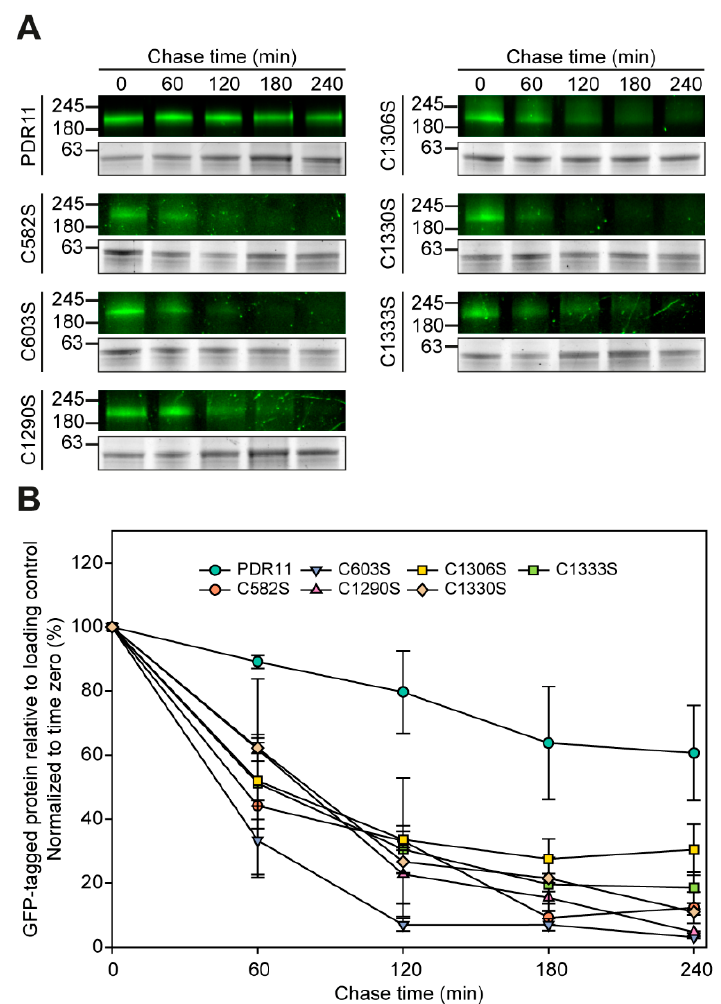
Figure 5. GFP-tagged Pdr11p cysteine mutants are less stable than the wild type. hem1 ∆ aus1 ∆ pdr11 ∆ cells expressing genomically integrated wild-type and mutant Pdr11p-GFP were treated with cycloheximide and processed at the indicated time points to monitor the stability of the ABC transporter. ( A ) Upper panels display in-gel GFP fluorescence and lower panels in-gel fluorescence detection at ~63 kDa for loading control. ( B ) The in-gel fluorescence intensities of GFP-tagged Pdr11p or cysteine mutant variants were quantified and normalized to the intensities of the loading control at ~63 kDa for each time point. Results are expressed as the percent change from time zero, which was set at 100%. Data are shown as the mean ± SD from two biological rep- licates.